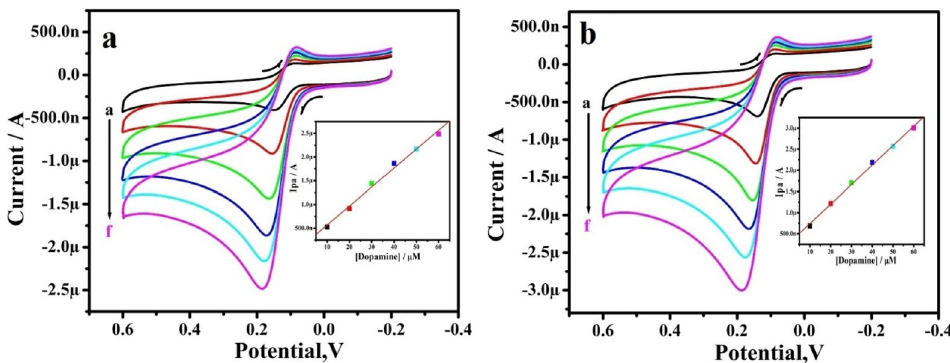
Figure 7. (a) CVs of DA (0.2 M PBS of pH 7.4) at RGO-Y 2 O 3 MCPE with various concentrations. b ) CVs of 10 μM DA (0.2 M PBS of pH 7.4) at RGO-Y 2 O 3 ; Cr 3+ MCPE with various concentrations. The inset figure (a,b) shows the graph of Ipa versus concentration of DA.